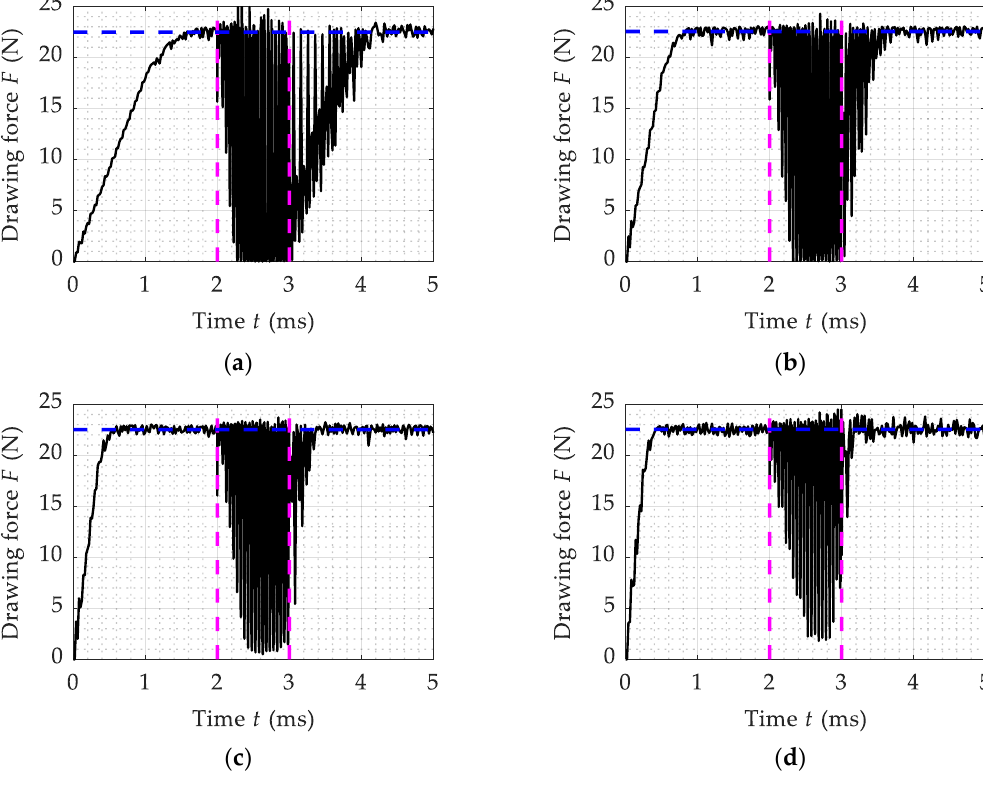
Figure 7. Influence of drawing speed on time-variation of the drawing force with reel-die distance of 126.4 mm: ( a ) V = 200 mm / s; ( b ) V = 400 mm / s; ( c ) V = 600 mm / s; ( d ) V = 800 mm /